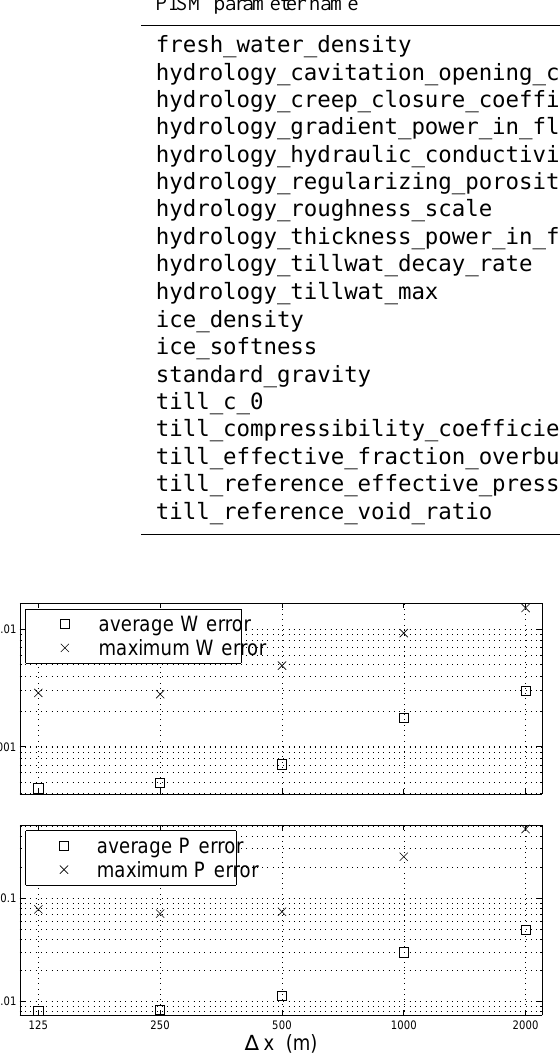
Figure 5. Average water thickness error | W − W exact | decays as O((cid:49)x 0 . 91 ) , and average pressure error | P − P exact | decays as O((cid:49)x 0 . 92 ) , for grids with spacing 250 ≤ (cid:49)x = (cid:49)y ≤ 2000m.